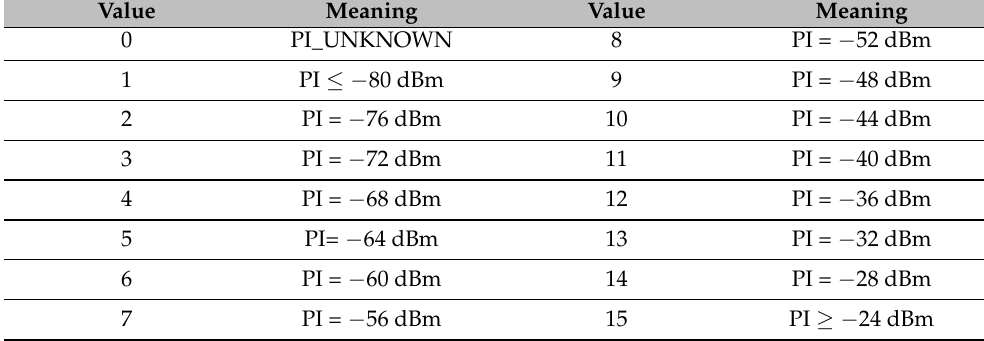
Table 2. Proximity information field encoding. The RSSI of the AP is quantized to a lower